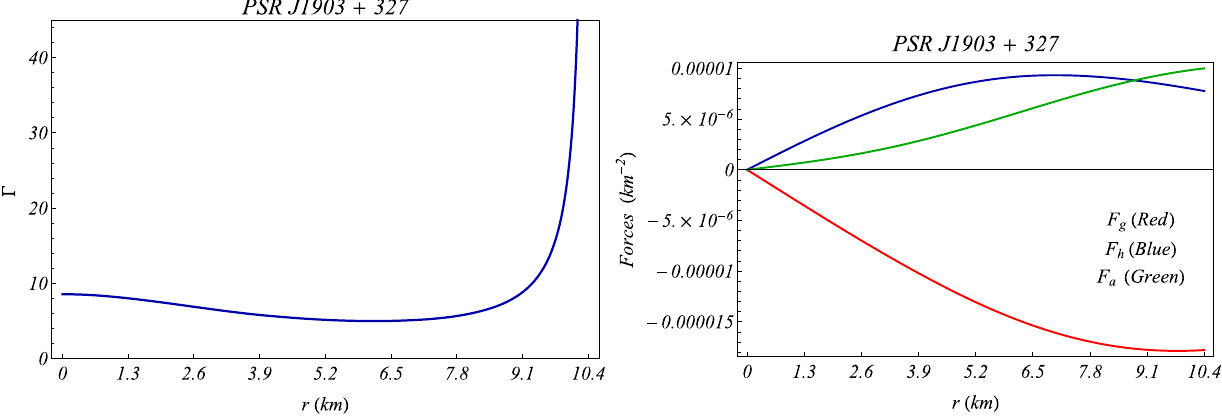
Fig. 8 (Left) The adiabatic index (cid:24) and (right) the forces acting on the system are shown against r inside the stellar interior for the compact star PSR